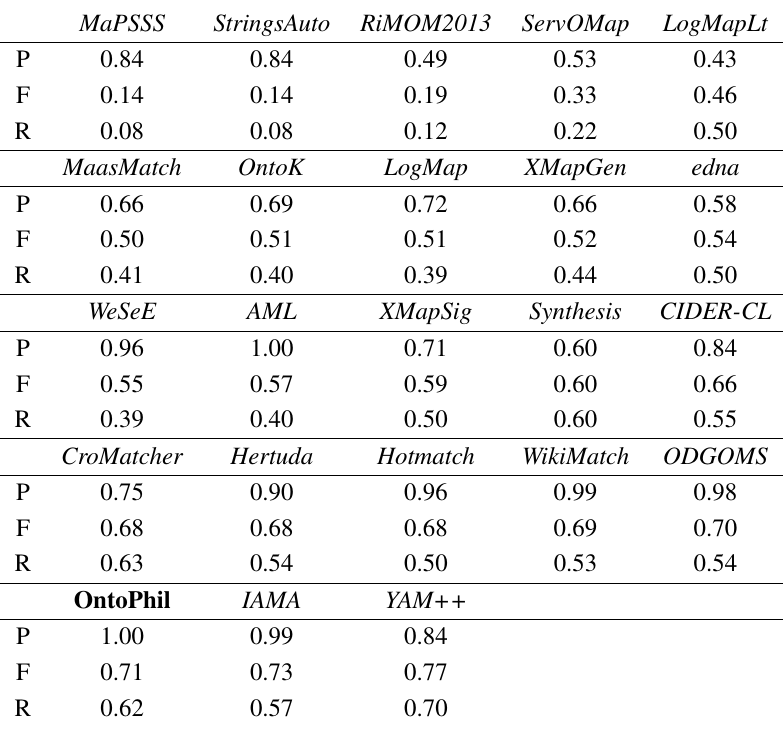
Table 1. Results obtained in the OAEI-13 benchmark track compared with OntoPhil (ordered by